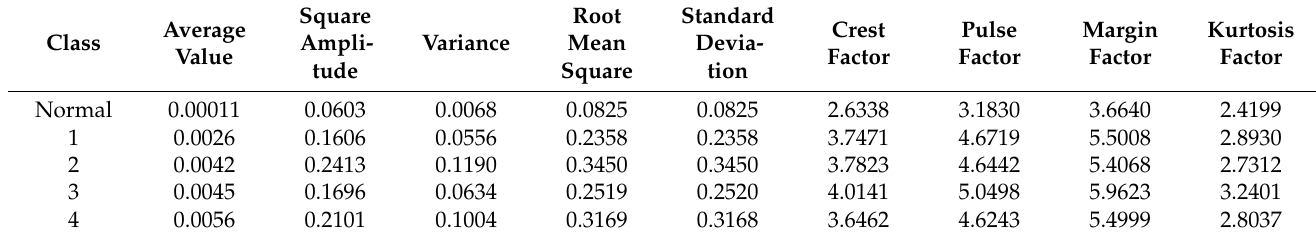
Table 3. Time domain features of vibration signal in x -axis direction.